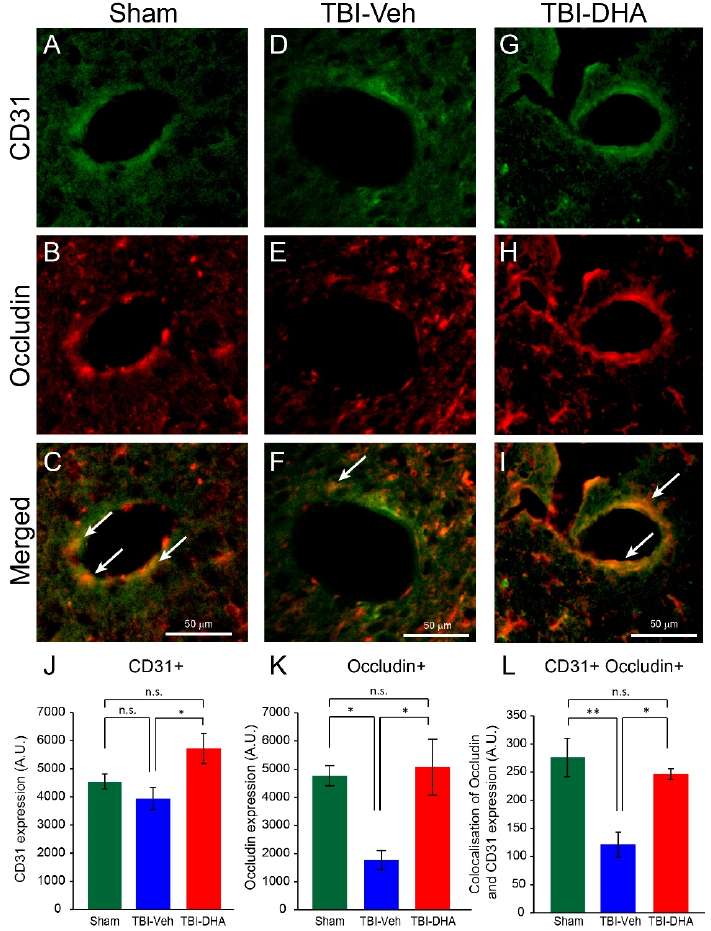
or occludin within CD31 immunopositive endothelial cells (white arrow) ( L ) at the pericontusional site revealed a significantly reduced loss of endothelial occludin expression in DHA-treated rats (red, n = 4) compared vehicle-treated TBI rats (blue, n = 4) at 7 days post injury. Endothelial occludin expression in sham-operated rats (green, n = 4) was significantly higher than vehicle-treated TBI rats. The * and ** indicate p < 0.05 and p < 0.01,